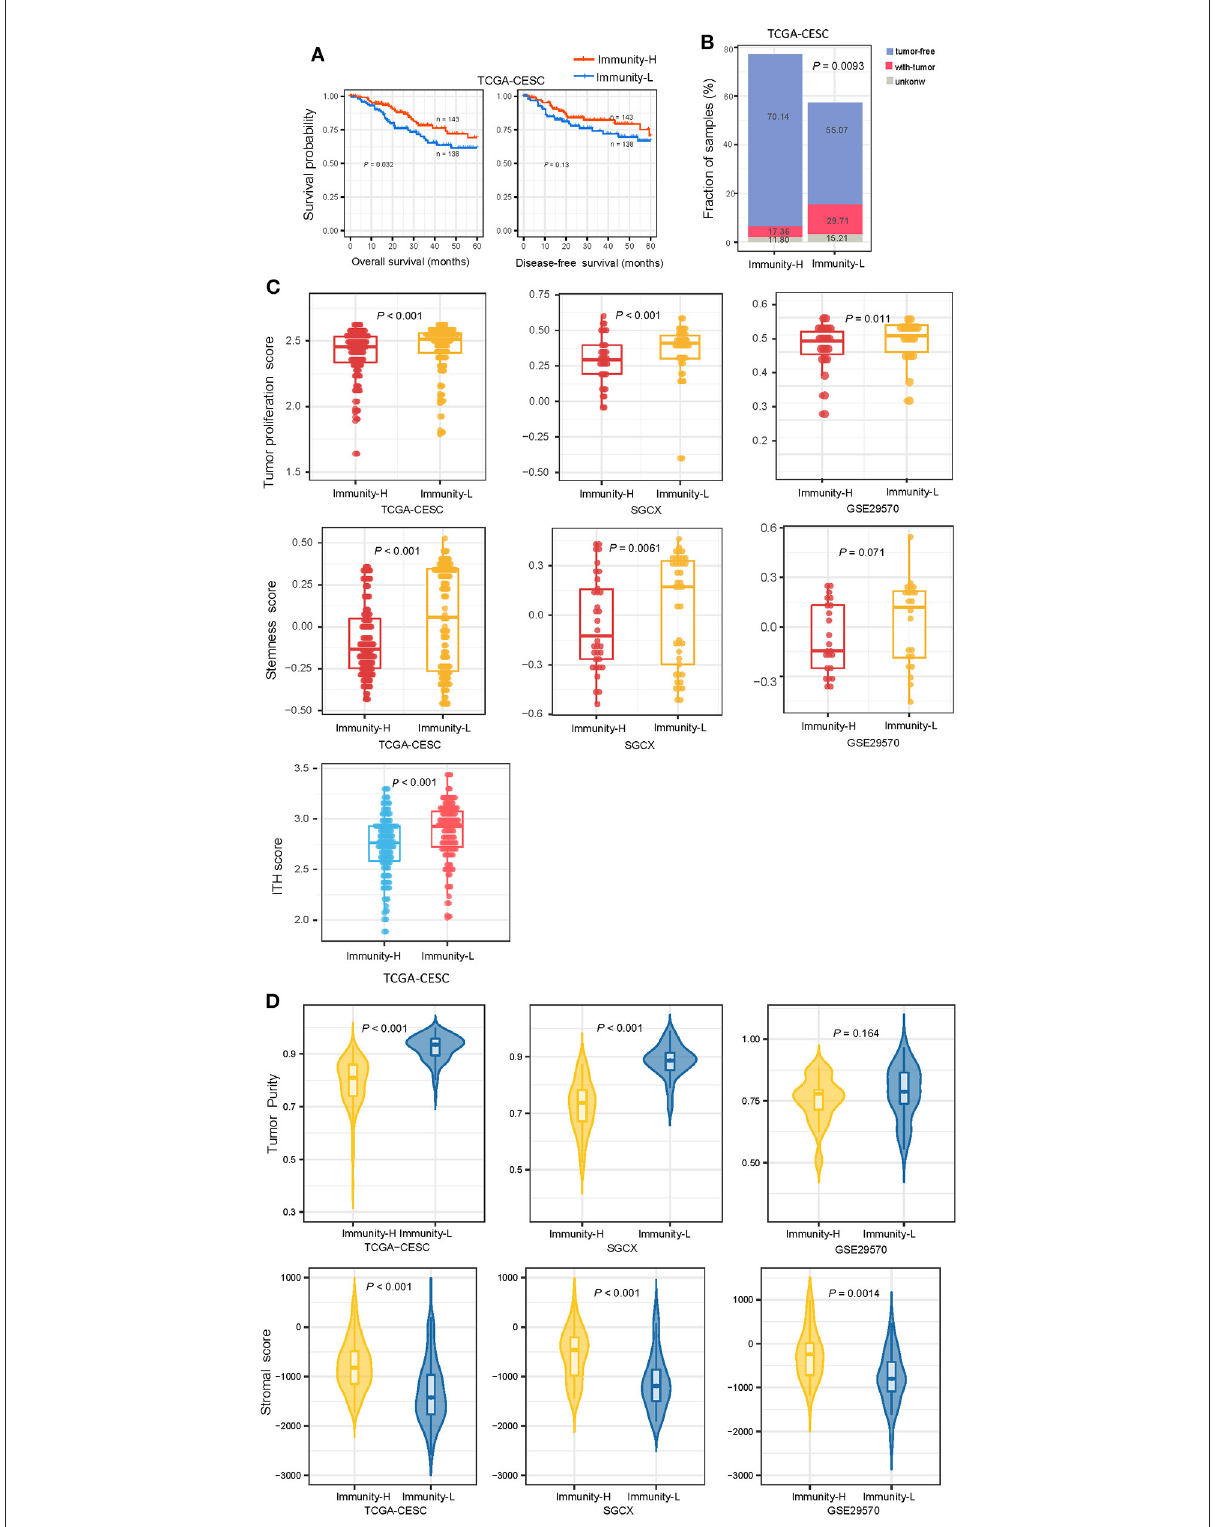
FIGURE2 Comparisons of clinical and molecular features between the immune subtypes of HPV + cervical cancer. (A) Kaplan–Meier curves showing 5-year overall survival and disease-free survival time differences between the immune subtypes. The log-rank test P -values are shown. (B) The proportion of tumor-free patients is significantly higher in Immunity-H than in Immunity-L The Fisher’s exact-test P -value is shown. (C) Immunity-H displays significantly lower enrichment scores of tumor proliferation, stemness, and ITH than in Immunity-L. (D) Comparisons of tumor purity and stromal content between the immune subtypes. The one-tailed Mann–Whitney U -test P -values are shown in (C,D) . ITH, intratumor